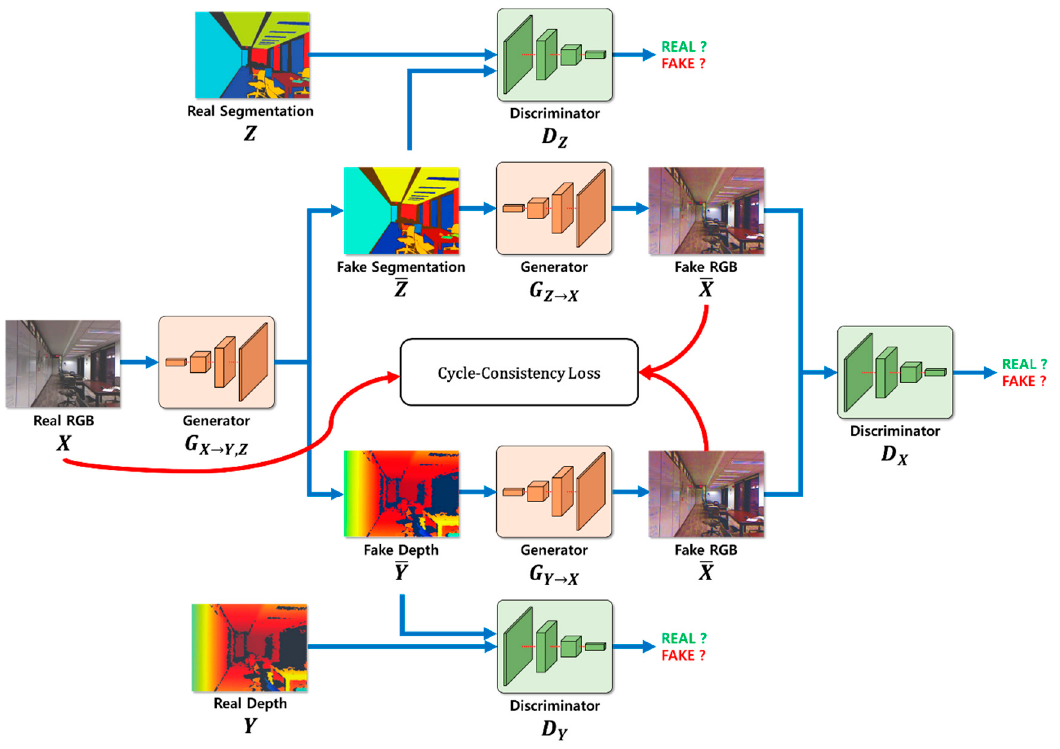
Figure 8. Operating sequences. Sensors 2020 , 20 , x FOR PEER REVIEW